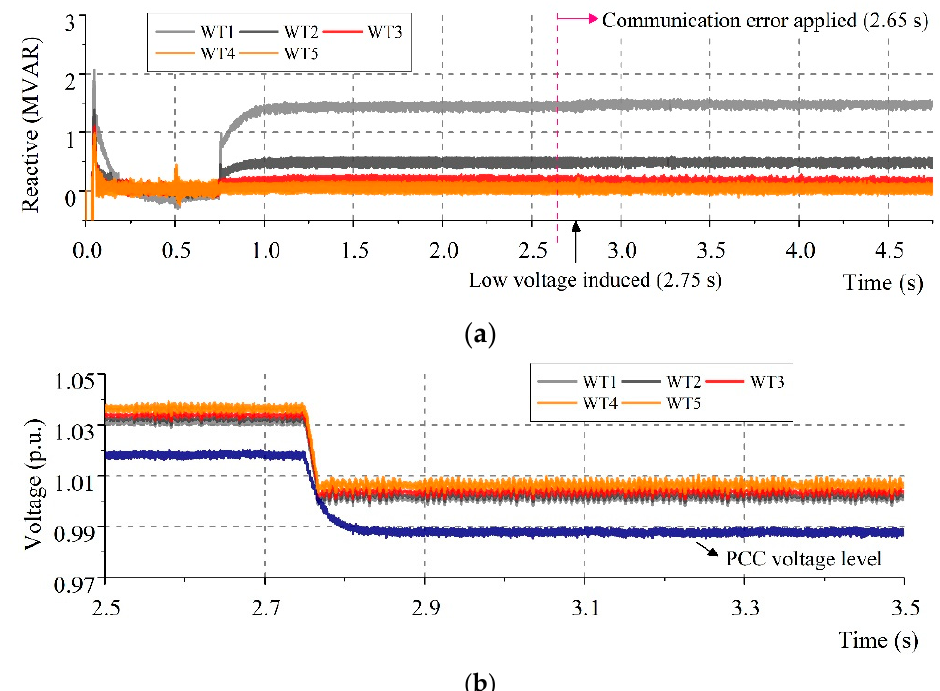
Figure 9. Reactive power supply from array 1 and voltage condition in case B—conventional algorithm, with ( a ) reactive power supply, and ( b ) voltage variation.